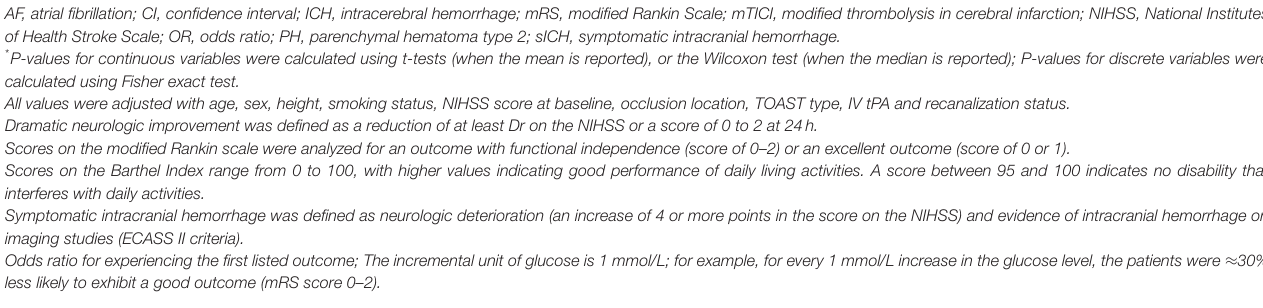
n Glucose, mmol/L P -value* Unadjusted OR P -value Adjusted OR (Mean ± SD) (95% CI) (95%